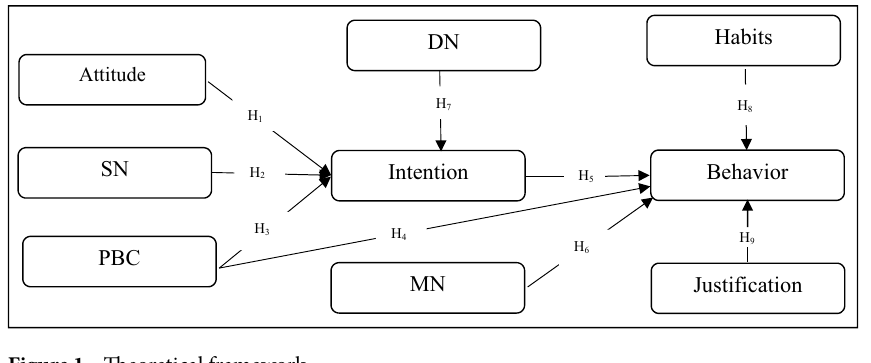
Figure 1. Theoretical